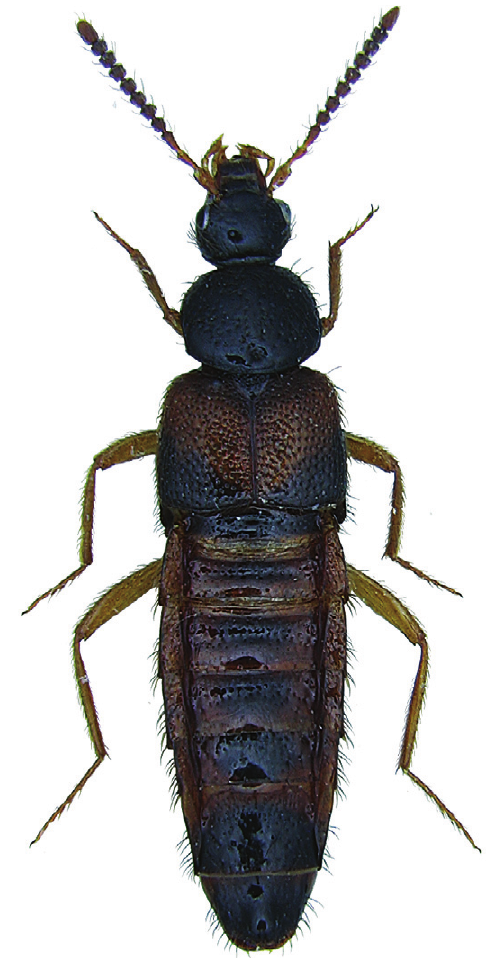
Figure 1. Zyras (Zyras) haworthi (Stephens), dorsal view (approximative length of photograped speci- men is 7.1